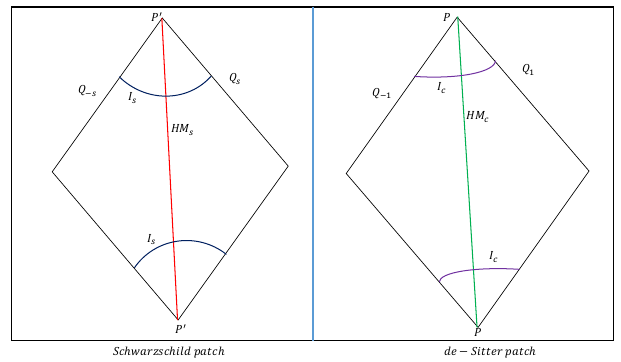
Figure 8 . Realization of Schwarzschild de-Sitter black hole in wedge holography. I s and I c are black hole and cosmological island surfaces (black hole and de-Sitter horizons in our case). Red ( HM ) and green ( HM ) lines are Hartman-Maldacena surfaces for Schwarzschild and de-Sitter s c patches. Q and Q branes consist of Schwarzschild and de-Sitter patches. Q s 1 to collect Hawking and Gibbons-Hawking radiation emitted by black hole and cosmological